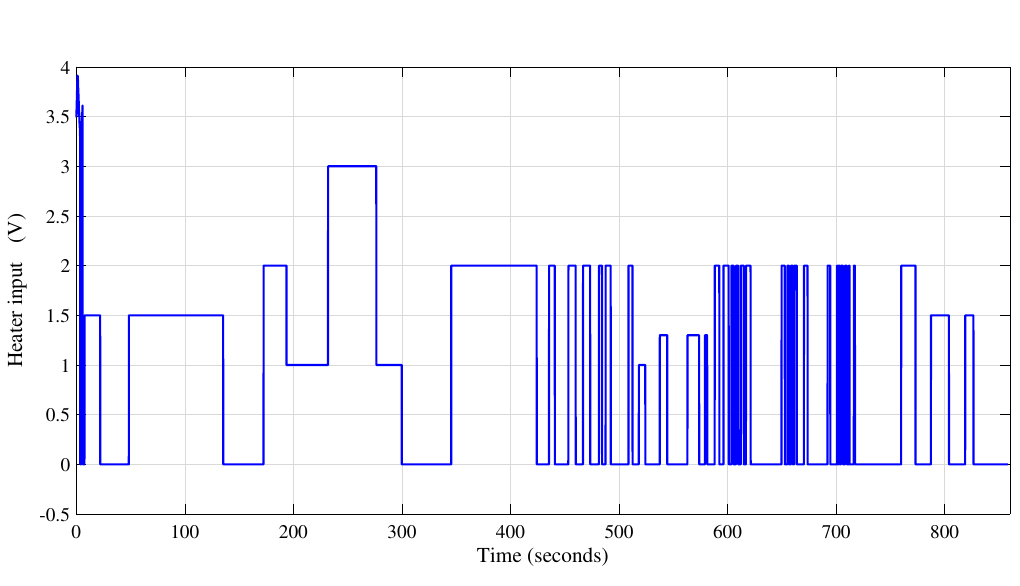
Figure 10: Input profile for state estimation